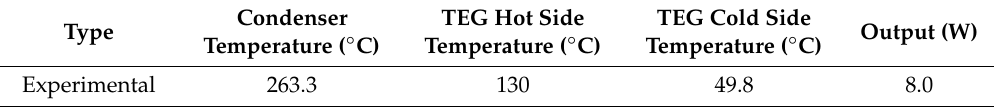
Table 7. Temperatures and output power of the TEG